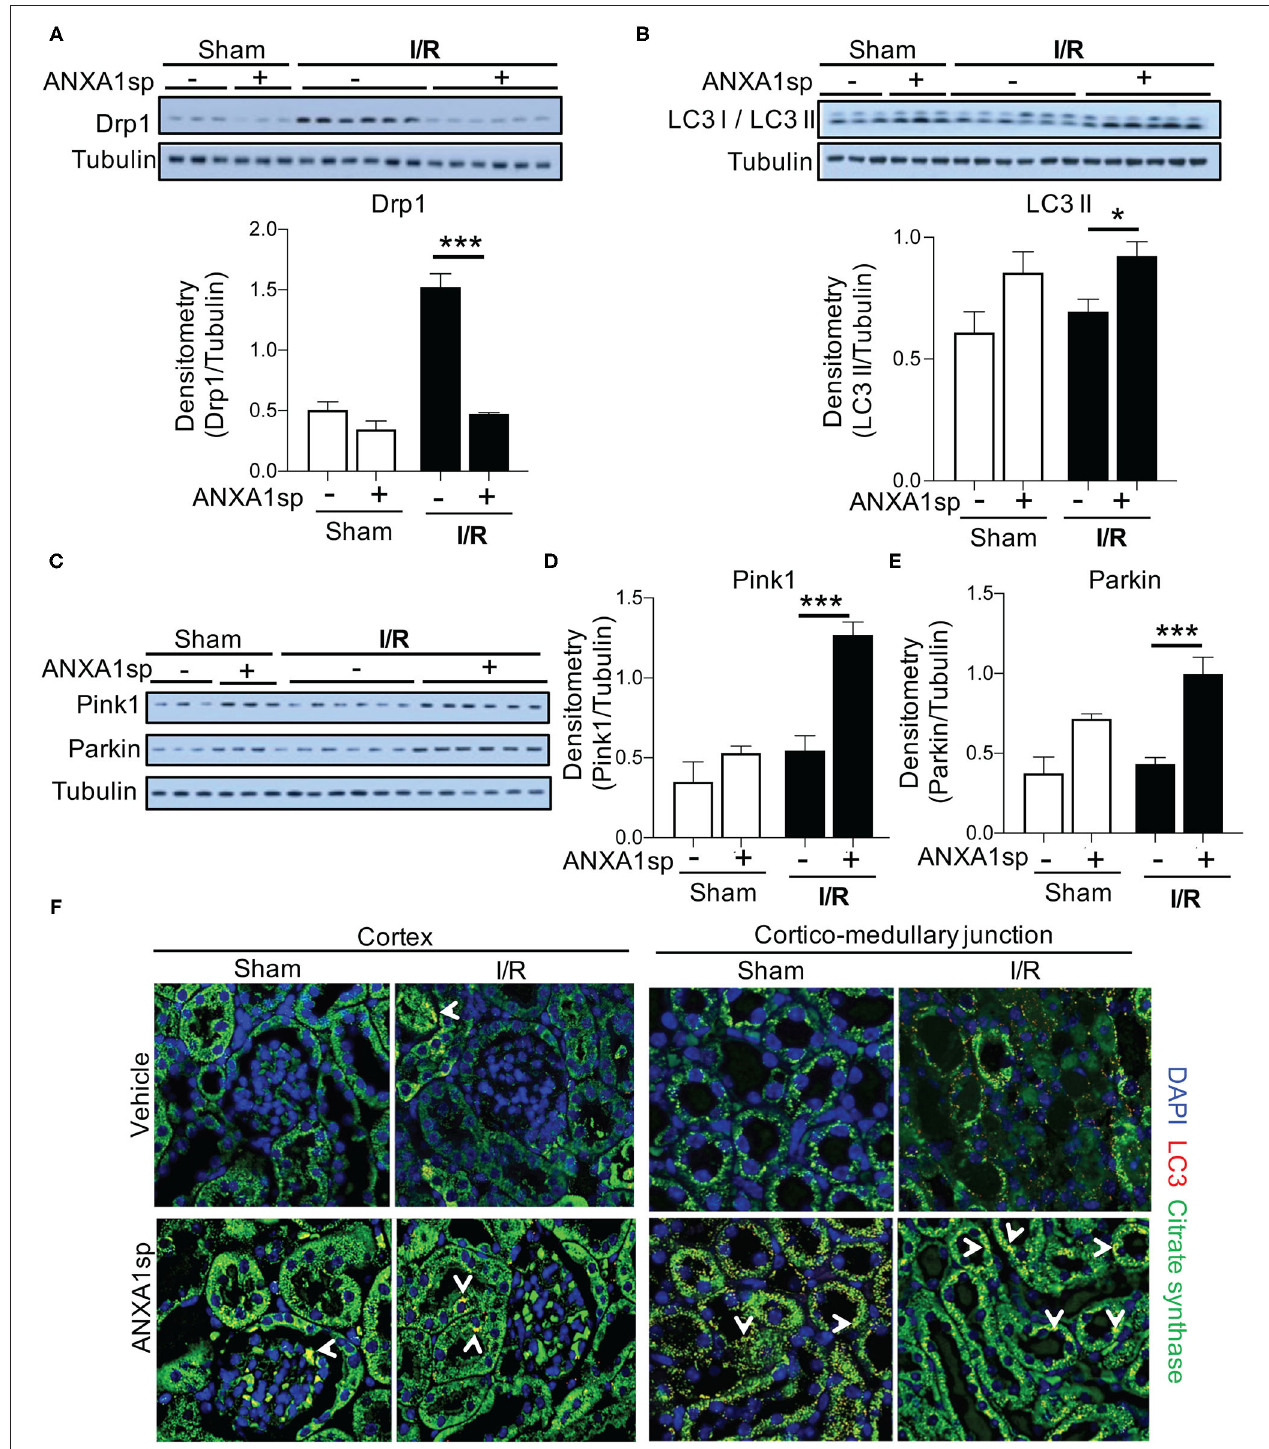
FIGURE 4 | ANXA1sp treatment improves markers of mitochondrial integrity. Mice were treated with either Vehicle or ANXA1sp 1h prior to ischemia, subjected to 33min of unilateral ischemia and contralateral nephrectomy, and then re-injected with Vehicle or ANXA1sp 1h after reperfusion. Kidney tissues were harvested at 24h after reperfusion. (A) Protein levels of dynamin-related protein (Drp)1 were determined by Western blot with densitometry shown in the graph below. (B) Western blot for LC3 I/LC3 II showing protein levels of indicated proteins with densitometry shown in the graph below. (C) Western blot for Pink1 and Parkin with densitometry shown in (D) and (E) , respectively. Graphs display mean + /-SEM of densitometry of protein normalized to tubulin. Statistical significance determined by two-way